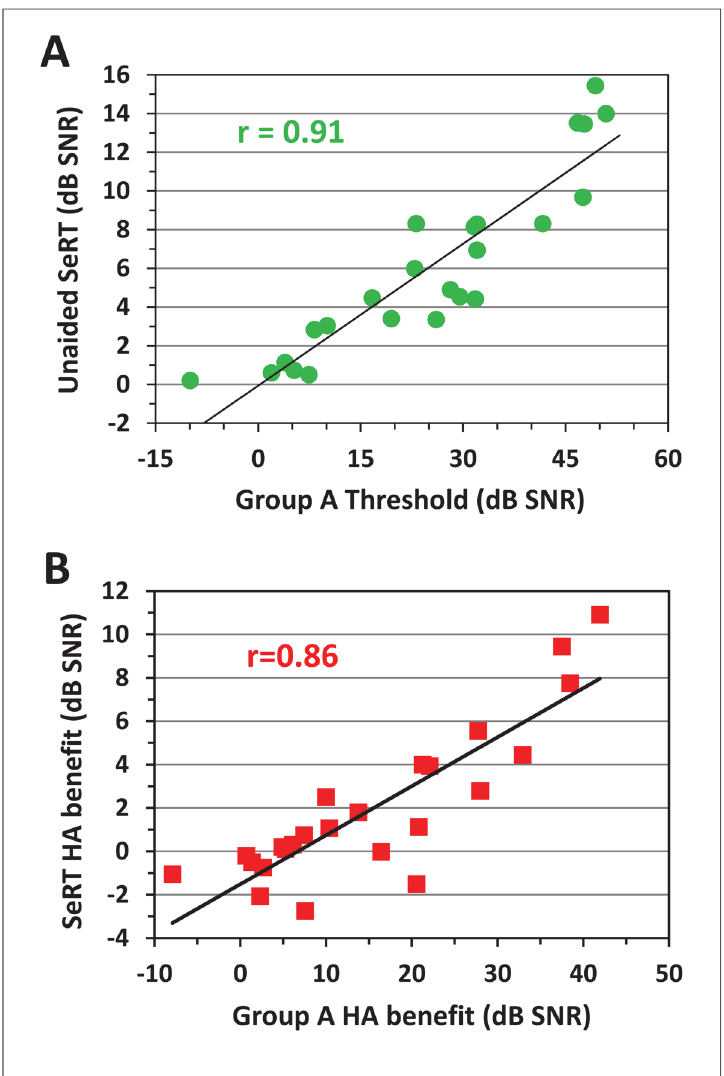
Fig 7. Scatter plots showing the relation between listeners ’ SeRTs and unaided Group A consonant identification thresholds (Panel A) and the relation between HA benefit on Group A consonants and HA benefit on SeRTs (Panel